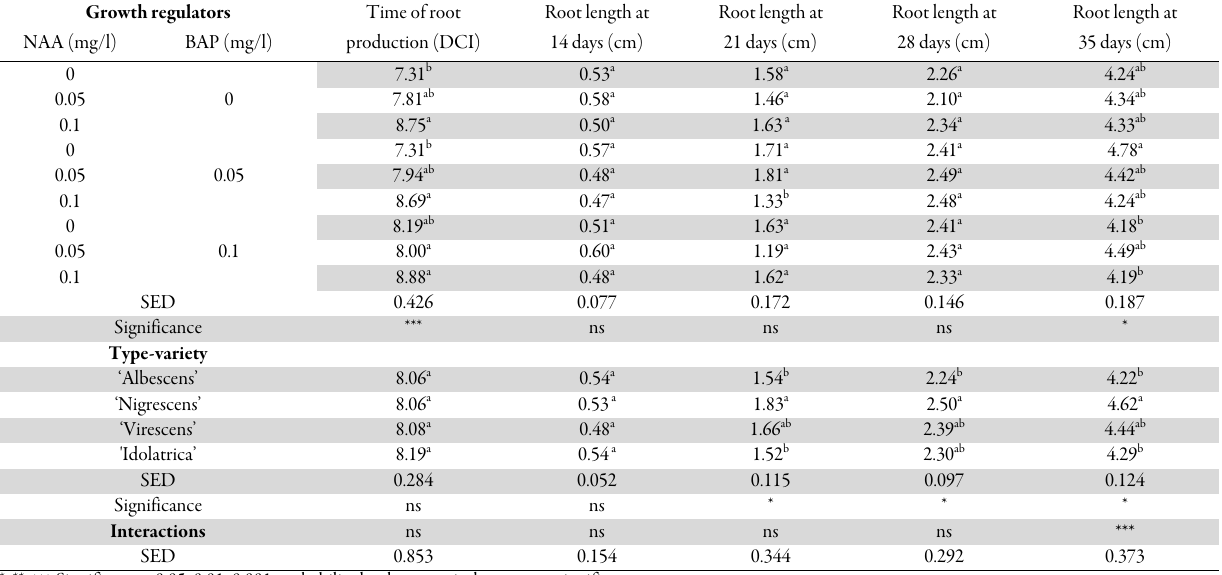
Table 1. Effects of growth regulators and type-variety of oil palm on the time of root production, root length at 14, 21, 28 and 35 days after culture initiation Growth